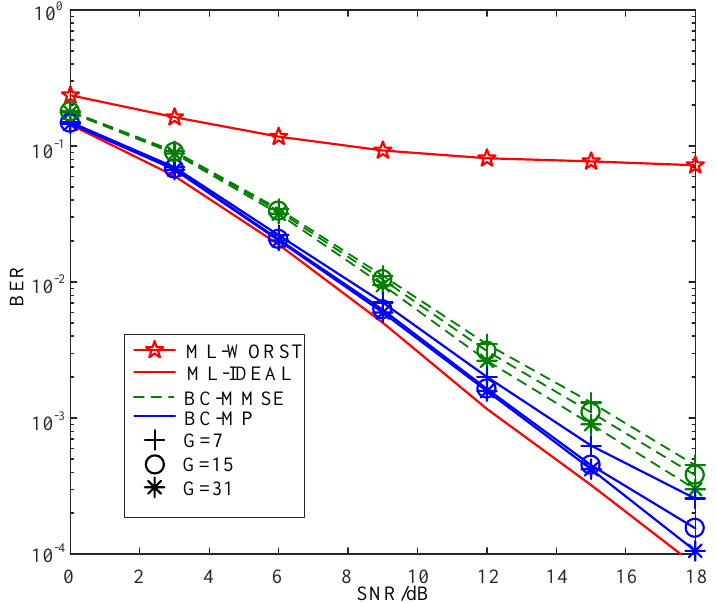
Figure 7. BER comparisons of the proposed BC-MMSE and BC-MP detectors for the GSTFIM systems with different numbers of effective subcarriers G in three iterations.